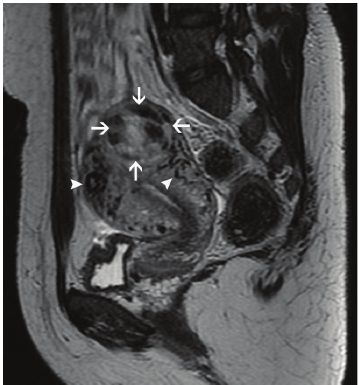
Figure 9: Sagittal T2-weighted MR image in a patient with invasive mole demonstrates a heterogeneous, hyperintense uterine mass in the fundus with a myometrial epicenter (arrows). Tortuous flow voids (arrowheads) consistent with vessels are seen in the adjoining myometrium, indicative of tumor